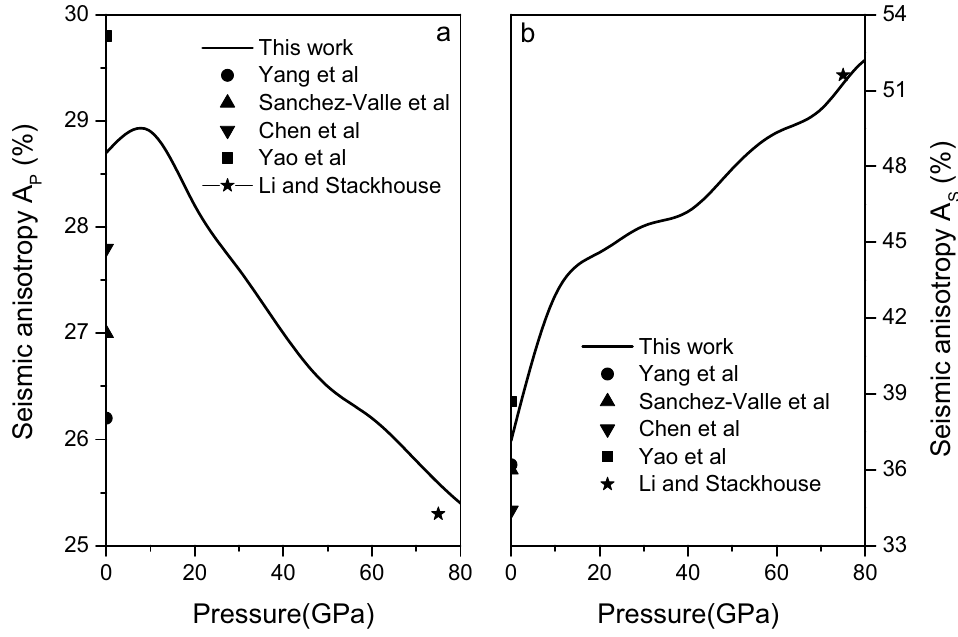
Figure 12. Anisotropy of plane ( a ) and shear ( b ) wave velocity of magnesite from 0 to 80 GPa.